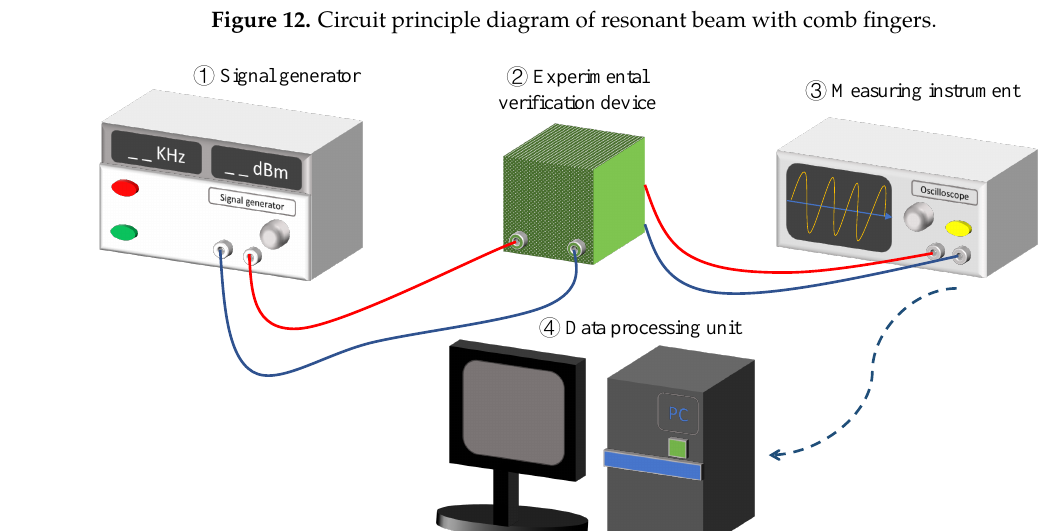
Figure 13. Diagram of experimental